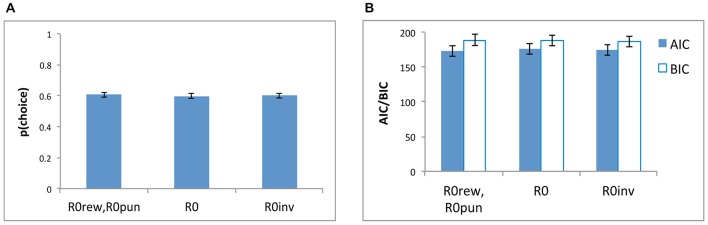
Model comparisons based on (A) p(choice) which is derived from negLLE (0.5 indicating chance and 1.0 indicating perfect fit), and (B) AIC and BIC, for the three models: the five-parameter model with where both R0rew and R0pun were free parameters (“R0rew, R0pun”), a simpler four-parameter model (“R0”) with a single free parameter for R0 (where R0rew = R0pun), and a four-parameter model (“R0inv”) where R0rew = −1*R0pun.